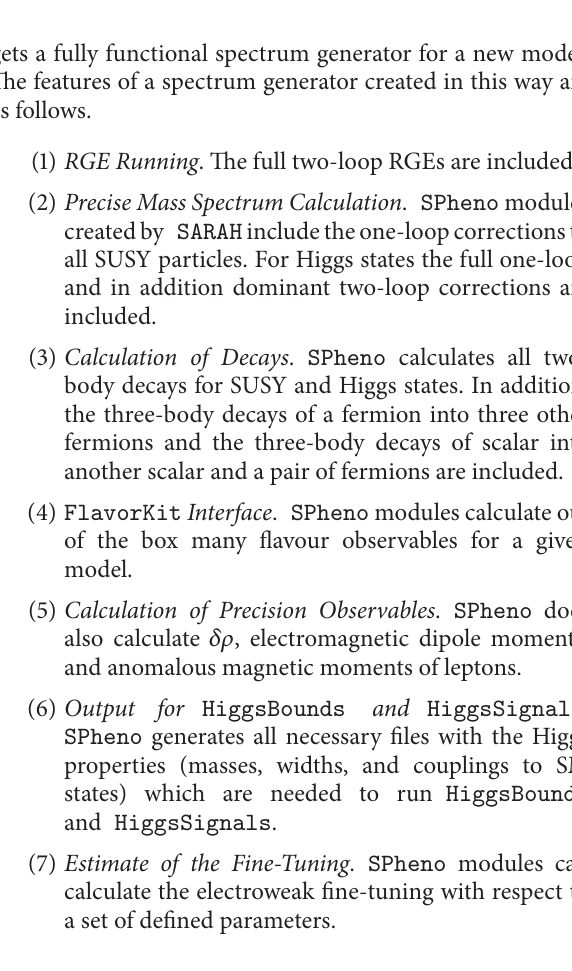
Figure 5: All tree topologies considered by FlavorKit to calculate the Wilson coefficients of 4-fermion operators. All possible generic combinations of the internal fields are taken into